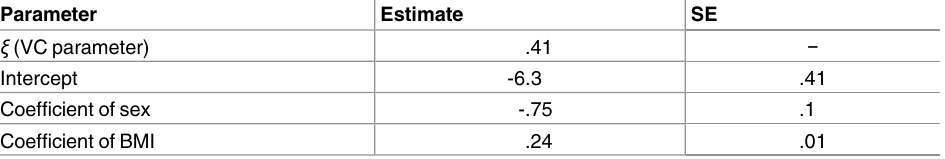
Sex is coded as female = 2, male =